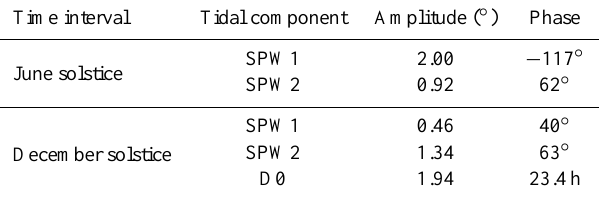
Table 2. Amplitudes and phases of the most prominent tidal com- ponents contributing to the modulation of ACL during June and De- cember